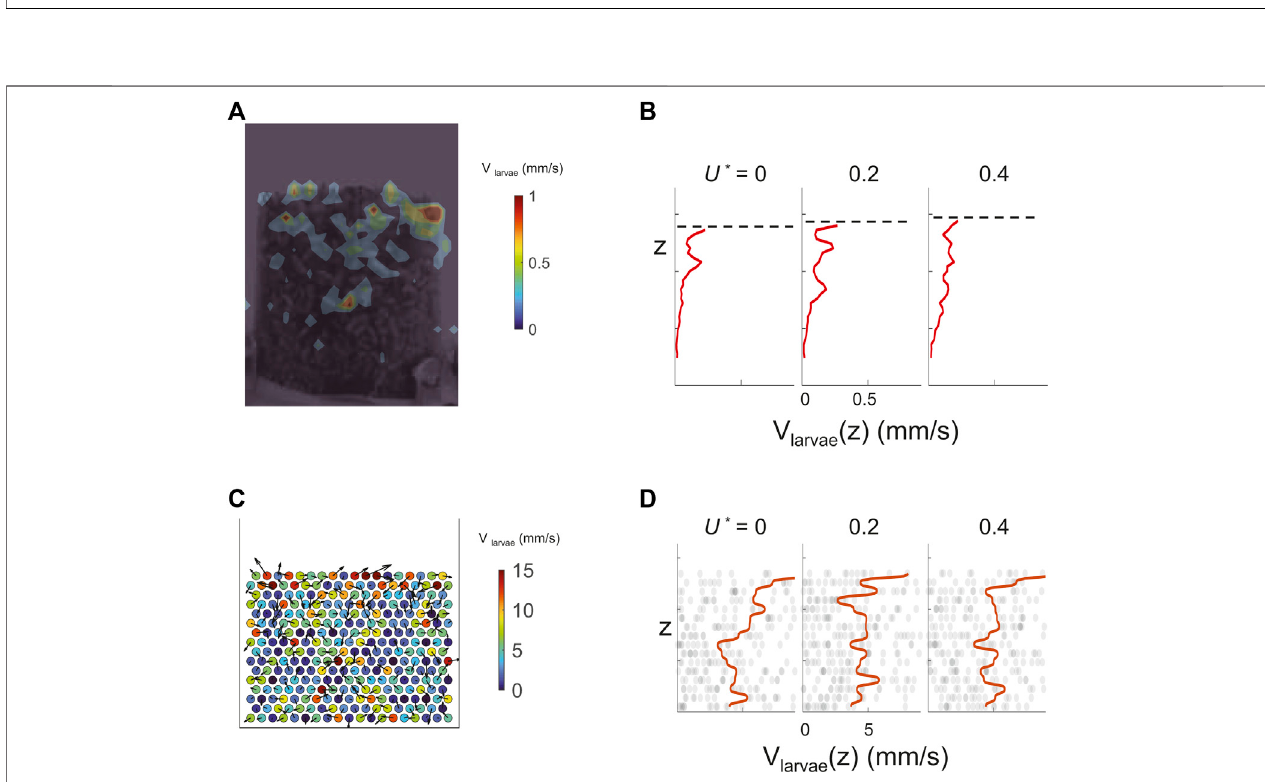
FIGURE 5 | Top layers of both live and simulated larvae move more rapidly. (A) Larval speed distribution at the boundary measured using Particle Image Velocimetry (PIV). The colorbar shows thescale inmm/s. (B) Average larvalspeed ( x -axis)at different elevation z ( y -axis).Elevation level z corresponds tothat inA.Dash linesmark the top surface of the larva aggregates in each snapshot. (C) Speed ofactive cylinders at the onset of fl uidization isshown using colorsand arrows. The color bar shows the scale in mm/s. (D) Average cylinder speed from simulation, the axes arrangement is the same as (B) .